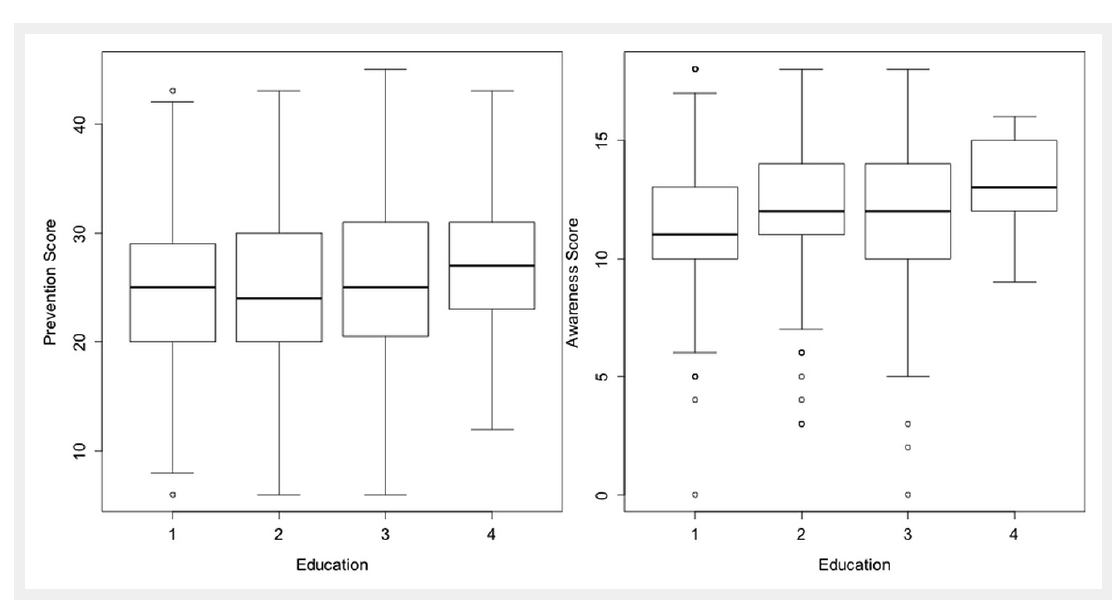
Box plots of the ultraviolet radiation prevention and the skin cancer awareness scores and the educational attainment of the participants, univariate level. The correlation between the UVR prevention score and educational attainment was not significant (p = 0.24). Educational attainment was significantly associated with the awareness score at univariate level only (p = 0.01). 1 is the highest and 4 the lowest educational level. The educational attainment of the participants was grouped into four different subcategories according to the Swiss educational system: (1) university degree, (2) school of applied science, (3) apprenticeship, and (4) basic